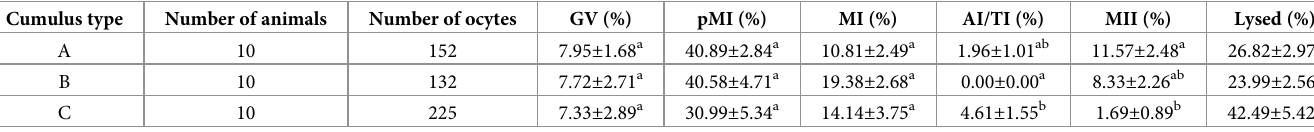
* Different superscript letters (a, b or ab) in the same column indicate statistical significance between different variables (P < 0.05). Type A oocytes have more than three layers of cumulus cells; type B oocytes have 1–3 layers of cumulus cells; type C oocytes have few or almost no cumulus cells. GV: germinal vesicle; pMI: pro- metaphase I; MI: metaphase I; AI: anaphase I; TI: telophase I; MII: metaphase